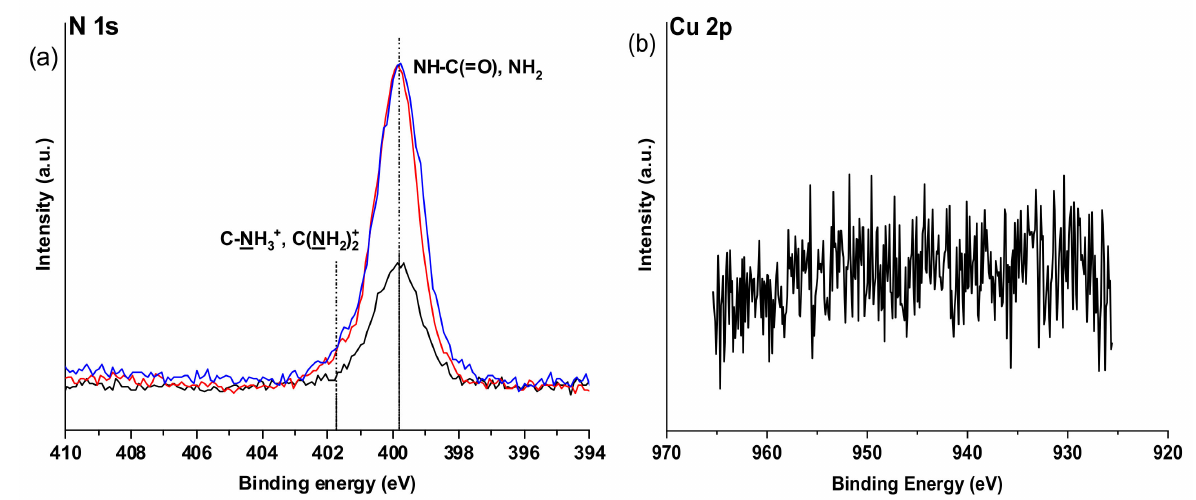
Figure 9. High resolution XPS spectra: ( a ) N1s spectra of Alg-PAm (black), Alg-PAm-RGD (red) and Alg-PAm-TYRAY (blue). The immobilization of the peptides leads to the rise of the amide signals at 399.9 eV and the protonated guanidinium group of arginine at 401.7 eV; ( b ) Representative high-resolution Cu 2p spectrum lacks peaks arising from Cu 2+